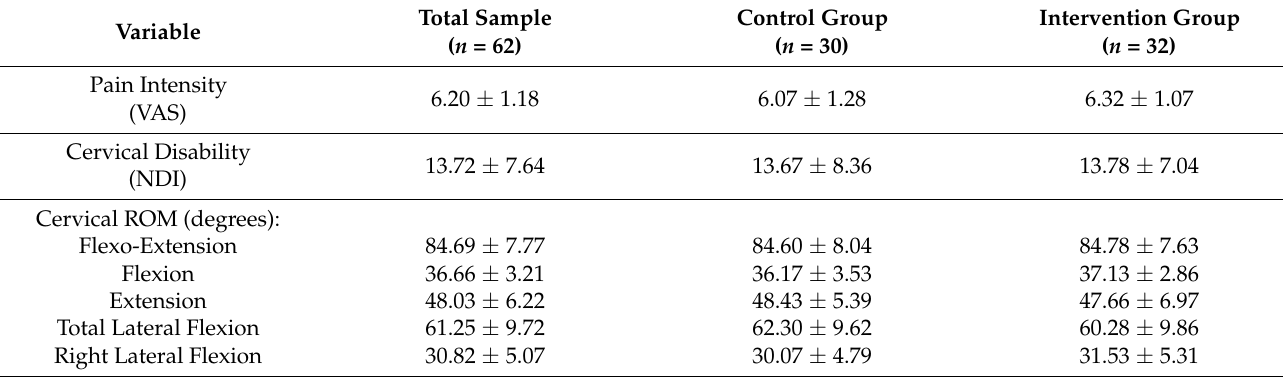
Table 2. Initial results (media ± standard deviation) of pain intensity, cervical and lumbar disability, flexibility, and range of motion of family